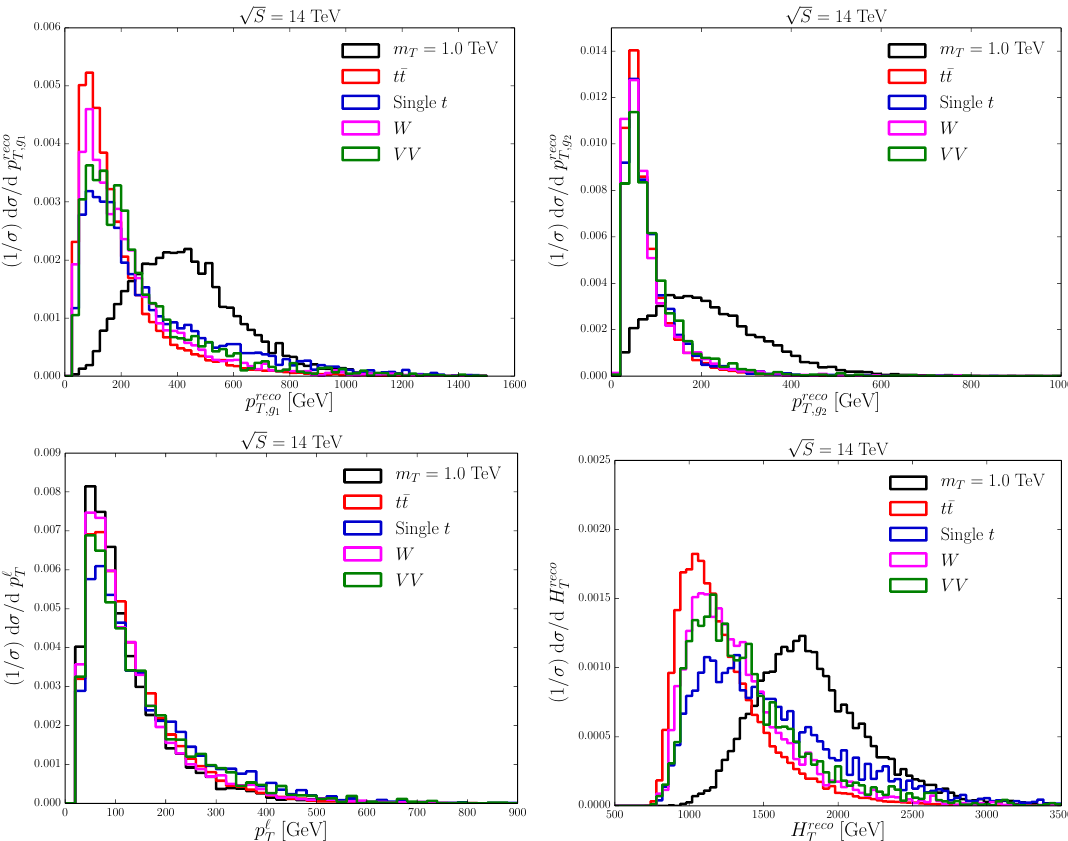
Figure 4 . The p T distributions of the (cid:12)rst (top-left) and second (top-right) hardest slim jets not associated with t lep or t had , and (bottom-left) the isolated lepton, in the ttgg channel for m T = 1 : 0 TeV. The scalar sum, H reco